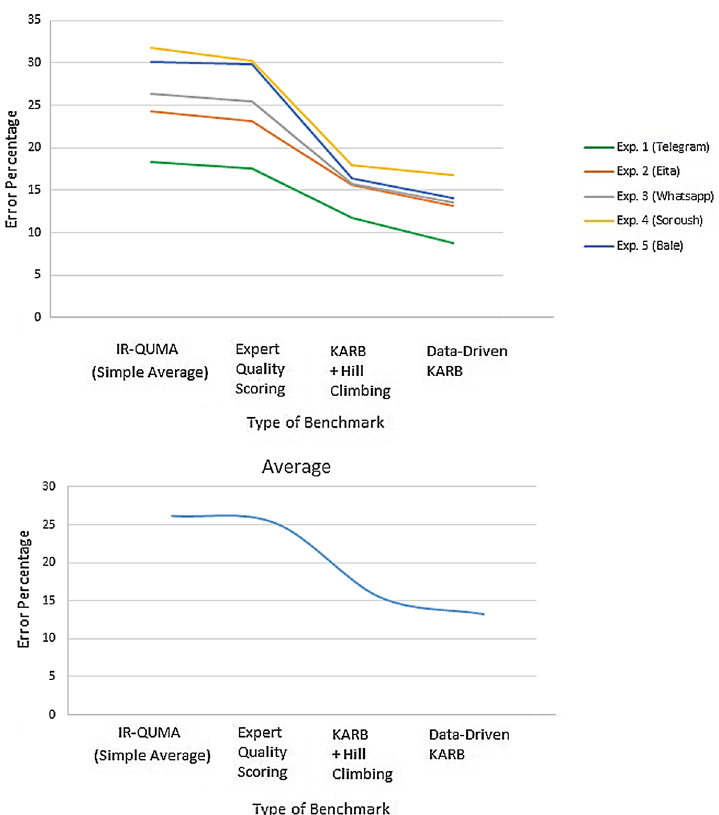
Fig. 12 Error reduction curves for five different experiments and their